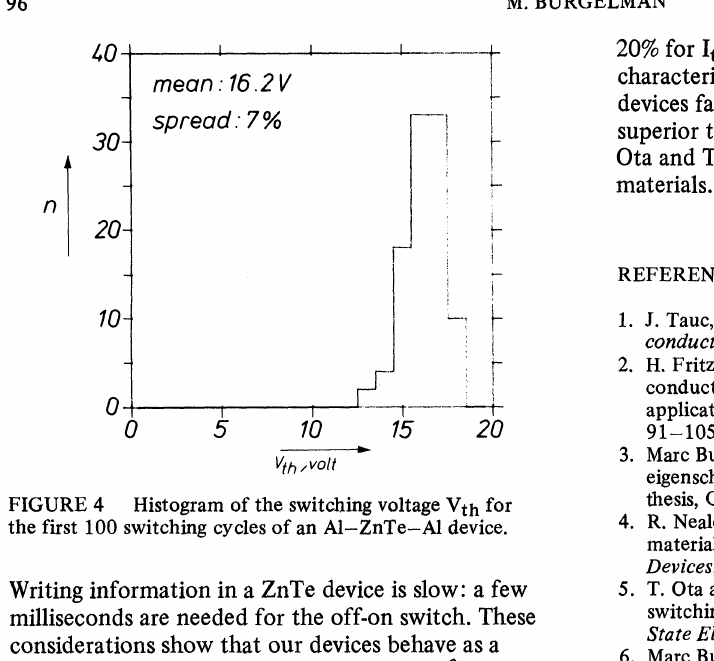
Histogram of the switching voltage Vth for the first 100 switching cycles of an A1-ZnTe-A1